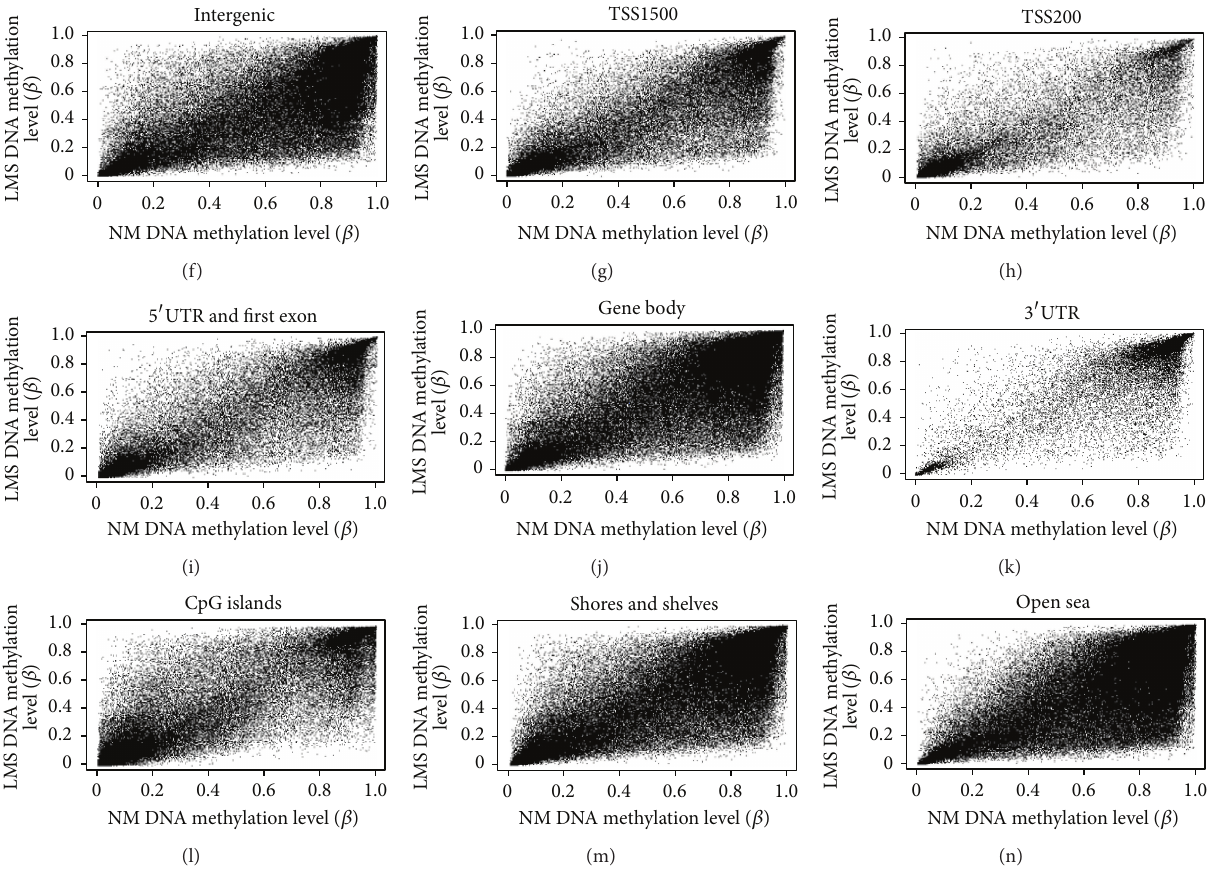
Figure 4: Comparisons and characterization of DNA methylation profiles of NM, LM, LMS, and LMS cell lines. (a) Flow chart showing results of quality control procedures and the extraction of differentially methylated probes and genomic regions. (b) Hierarchical clustering of 12 samples using 𝛽 values of 471,511 probes that passed the data QC procedures (see (a)). (c) Boxplots of 𝛽 values for the 471,511 probes that passed QC procedures for 12 samples analyzed in this study, as well as boxplots of the entire 𝛽 values of HumanMethylation450 BeadChip data for ten cell lines obtained from the ENCODE DNA Methylation Track (http://hgdownload.cse.ucsc.edu/goldenPath/hg19/encodeDCC/ wgEncodeHaibMethyl450/). Whereas LMS tissues exhibited global hypomethylation tendencies, LMS-derived cell lines did not. To assess whether observed global methylation levels (normal or hyper) are specific to LMS-derived cell lines, we examined those of six cancer cell lines (K562, A549, HeLa-S3, HepG2, MCF-7, and SK-N-SH) and confirmed their highly various levels. The DNA methylation profiles of these cancer cell lines as well as LMS-derived cell lines are likely extensively deviated from those of their origin (a cancerous tissue). (d) Scatter ( 𝑥 - 𝑦 ) plots showing the average 𝛽 values of each sample for the 471,511 probes (NM versus LM, NM versus LMS, and LM versus LMS). (e) COBRA assays for LINE1 methylation. 413-bp and 246-bp bands represent uncut (unmethylated) and cut (methylated) bands upon Hinf I digestion, respectively. The methylation index (%) was calculated as (the intensity of the cut band/246)/((the intensity of the cut band/246) + (the intensity of the uncut band/413)) and shown at the bottom. The measured methylation index was corrected using the standard curve (SupplementaryMaterial,FigureS2)obtainedwiththemethylatedandunmethylatedcontrolbisulfite-convertedDNAs(EpiTectPCRControl DNA Set #59695, Qiagen). The corrected methylation levels (%) are shown in parentheses. Though the LINE1 methylation levels of LM were similar to those of NM, LMS samples showed lower levels of LINE1 methylation. (f)–(k) Scatter plots of 𝛽 values (LMS average ( 𝑦 -axis) versus NM average ( 𝑥 -axis)) in the six gene feature groups. (l)–(n) Scatter plots of 𝛽 values (LMS average ( 𝑦 -axis) versus NM average ( 𝑥 -axis)) of three subgroups in relation to CpG islands (CGIs): CGIs (l), CGI shores and shelves (within 4 kb distance from a CGI) (m), and non-CGI regions (over 4 kb distance from a CGI, open sea) (n). CpG sites within CGIs, the majority of which are unmethylated, were found to be more frequently hypermethylated (4.5%) than those outside of CGIs (2.5% in open sea) and to be much less frequently hypomethylated (4.6%) than those outside of CGIs (16.7% in shores and shelves, and 28.1% in open sea) (Table